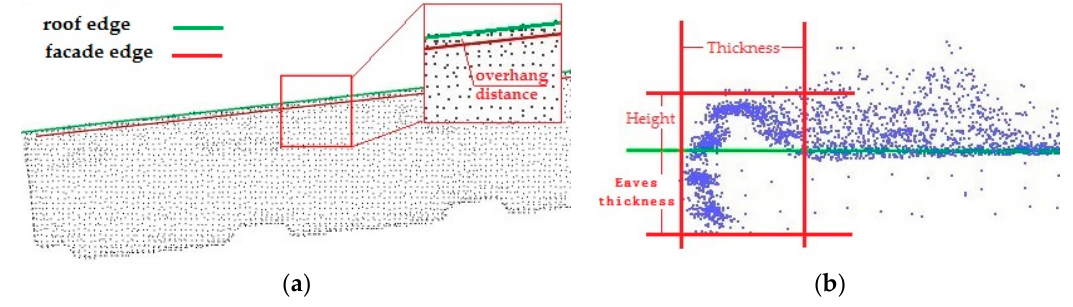
Figure 10. The height, thickness of the parapet wall, and distance of overhang: ( a ) the overhang distance, façade edge is intersection between roof and façade plane; and ( b ) the thickness and height of the parapet wall and the thickness of the eaves.